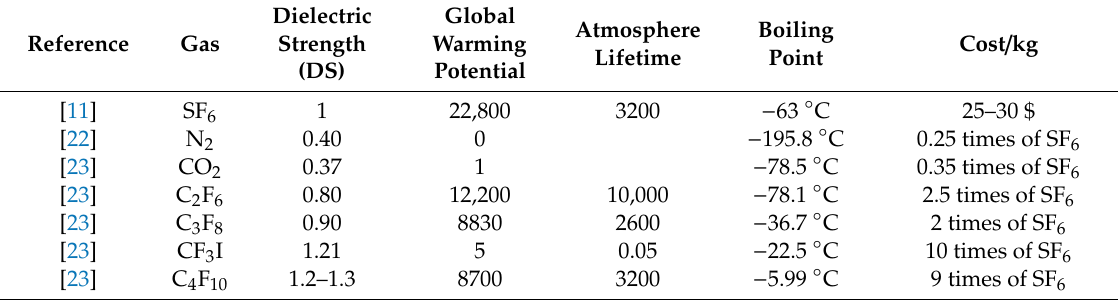
Table 3. Di ff erent alternative of SF 6 gas. The global warming potential represents the values over a time span of 100 years for equal masses of these gases.